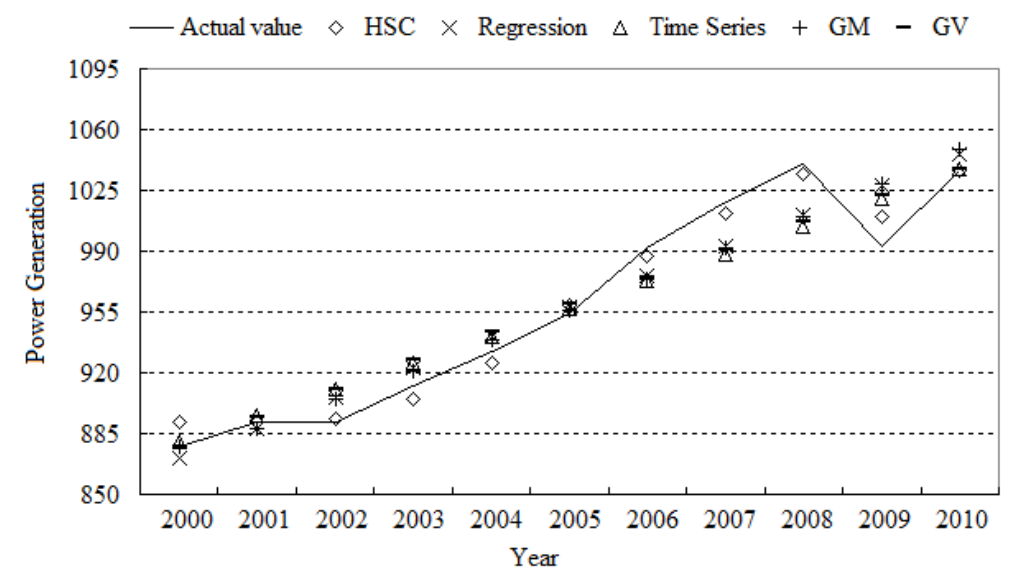
Figure 4. Forecasting performance of HS based JPOC model and other four single models for Russian Federation.